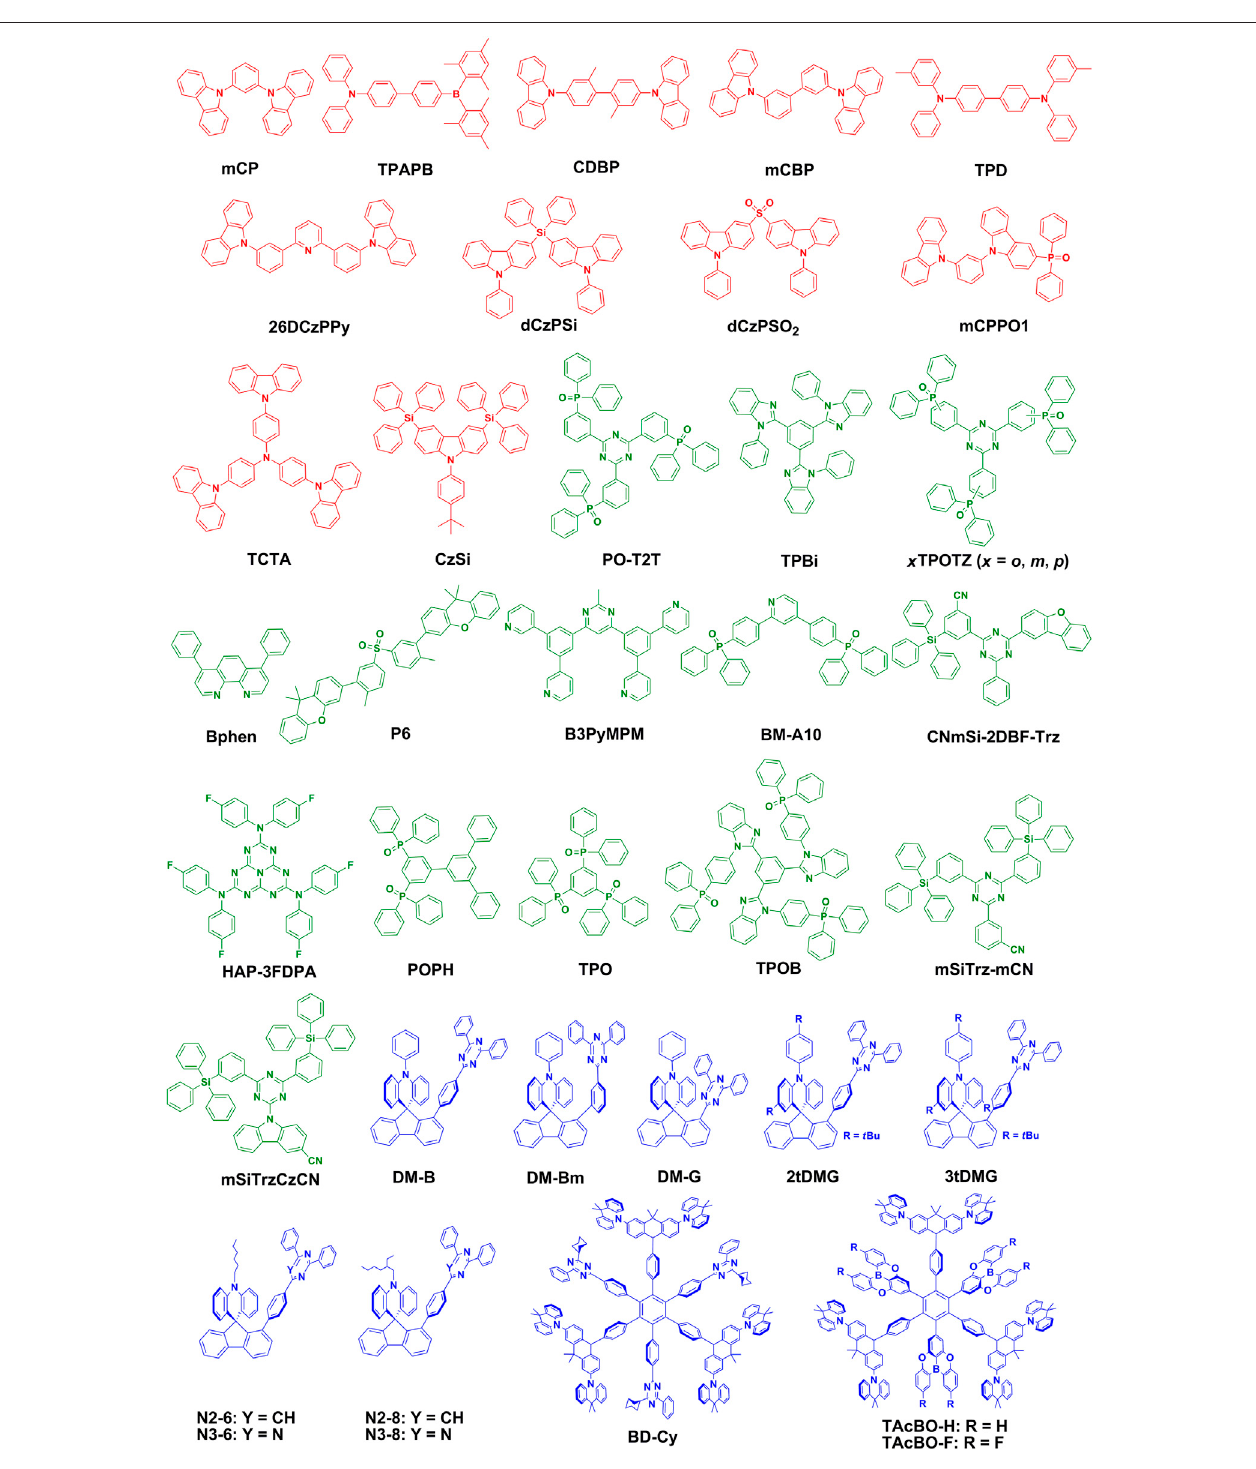
FIGURE 1 | Chemical structures of compounds forming blue exciplexes. The red, green, and blue colors represent donors, acceptors, and intramolecular exciplexes, respectively.